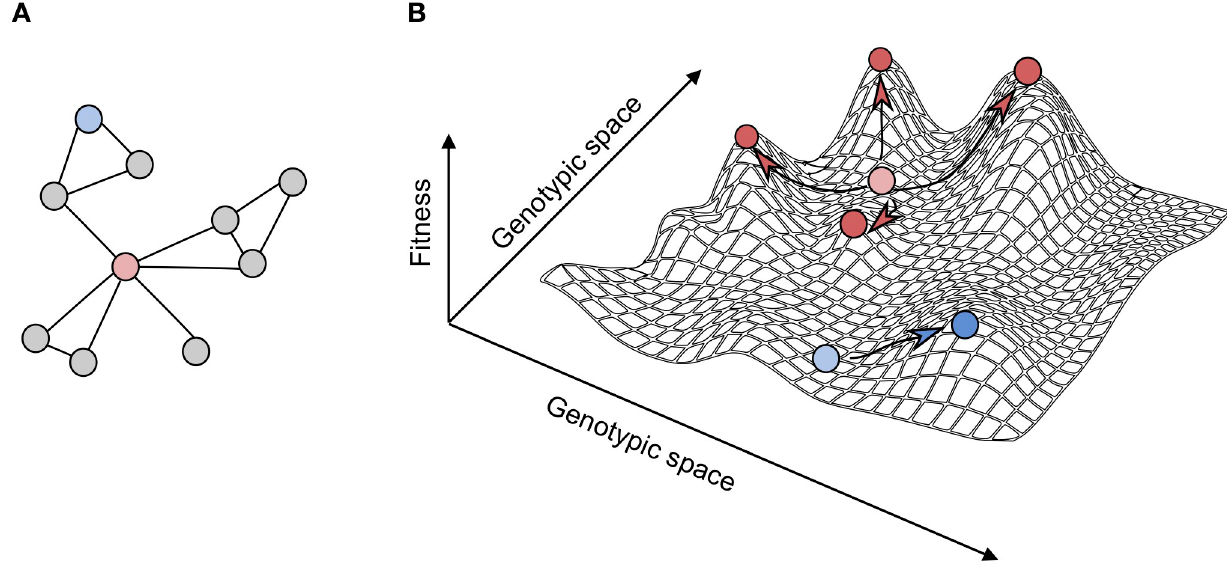
Fig 1. Network architecture determines evolutionary trajectories. (A) Simplified schematic of a gene network. The red node is a hub gene, and the blue node is a gene at the edge of the network. (B) Fitness landscape and possible evolutionary trajectories. Perturbing a hub gene (red) or a peripheral gene (blue) can both lead to a decrease in fitness, but the number of available evolutionary trajectories (arrows) is higher when a hub gene is perturbed.